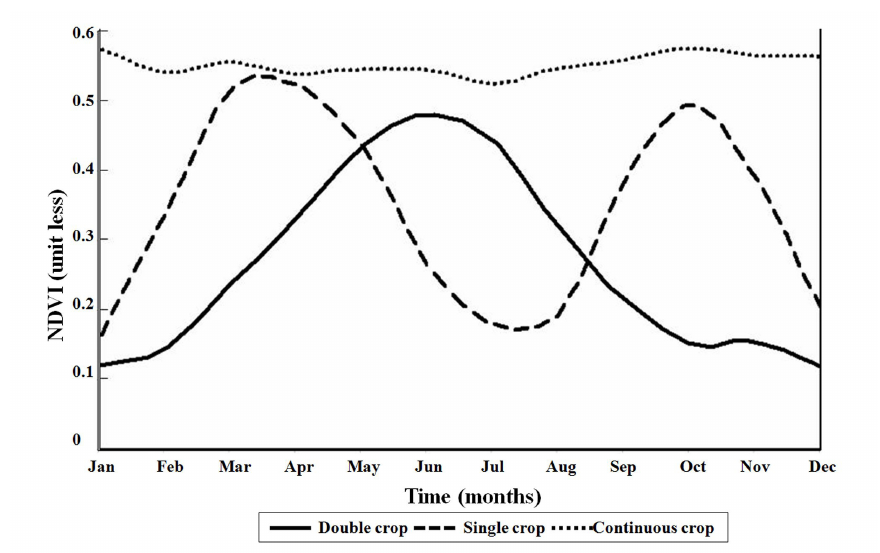
Figure 5. Intensity of irrigation and areas. Irrigated areas determined considering intensity (single crop, double crop, continuous crop in a season). Also, see Table 1 and